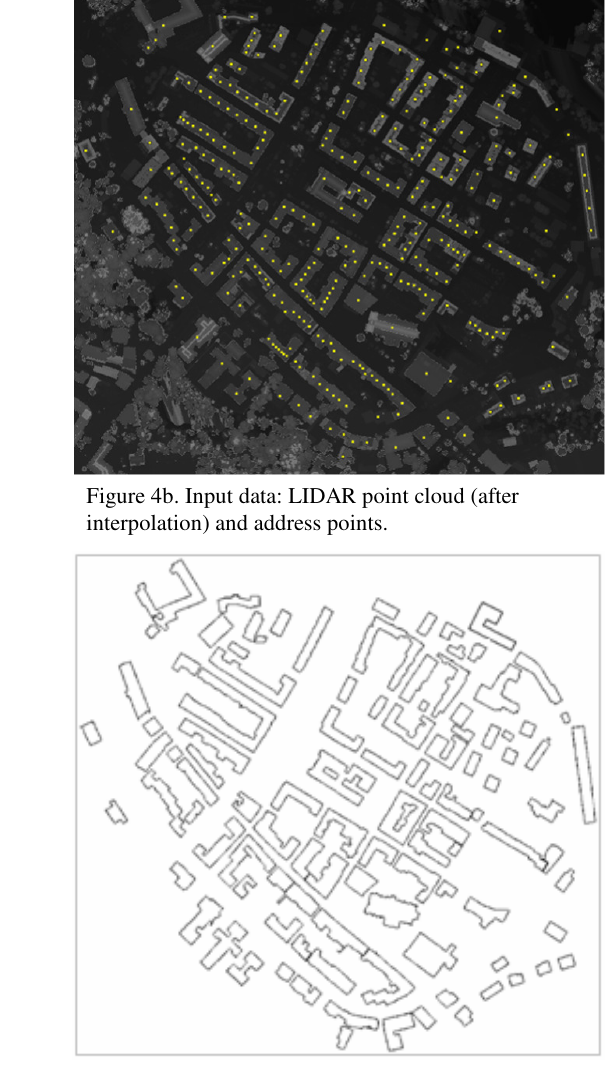
Figure 4c. Detected separated clusters of adjacent buildings.